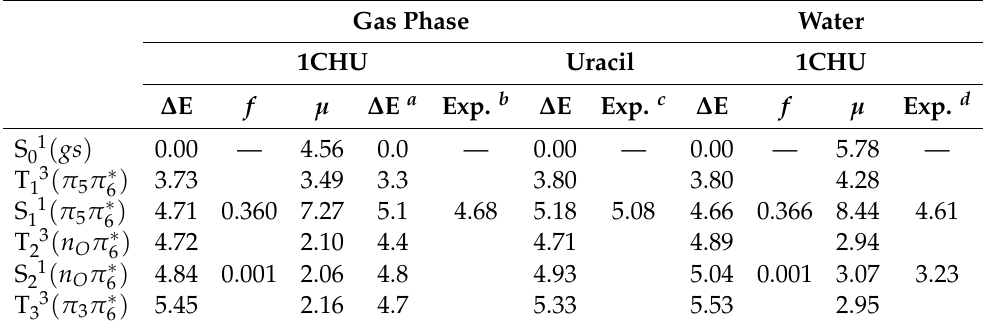
Table 2. Vertical excitation energies ( ∆ E, eV), oscillator strength ( f ), and dipole moment ( µ , Debye) for 1CHU in gas phase and water obtained at the MS(3S+3T)-CASPT2(12,9)/cc-pVDZ level of theory at the Franck–Condon region. Solvents effects were taken into account with the Polarizable Continuum Model (PCM). Uracil ground state geometry optimization and the corresponding vertical excitation energies were obtained at the same level of theory employed for 1CHU. Experimental absorption peaks (Exp.), obtained in ethyl acetate and aqueous solutions, together with previous theoretical results reported for 1CHU, are also displayed for